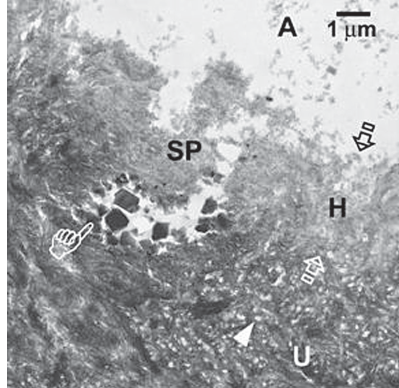
FIGURE 6 - Stained, undemineralized section. A thick layer of caries-infected dentin was present, containing loose dentin fragments(L) and bacteria(B). The extent of the hybrid layer could not be clearly discerned. It is likely that the self- etching primer did not reach and infiltrate beyond the layer of caries-infected dentin and did not form a hybrid layer into the underlying caries-affected dentin(CA). A gap(asterisk) was present between the unfilled primer caries-infected dentin. This gap was subsequently filled up with the more electron-lucent epoxy resin that was used for laboratory specimen